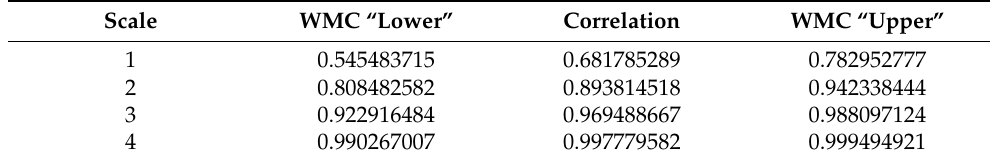
Table 4. WMC among the indicators of GSE and interest rates.